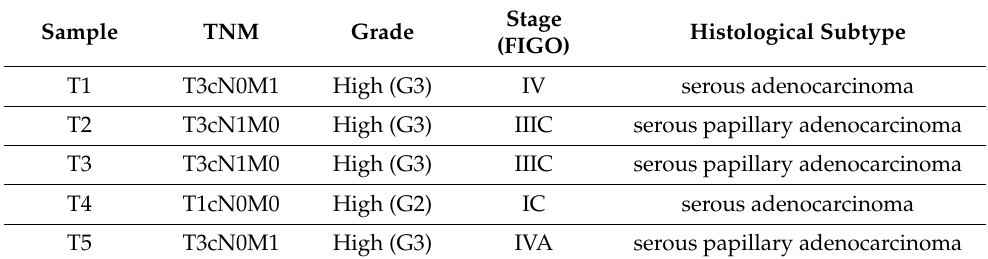
Table 1. Clinico-morphological characteristics of EOC